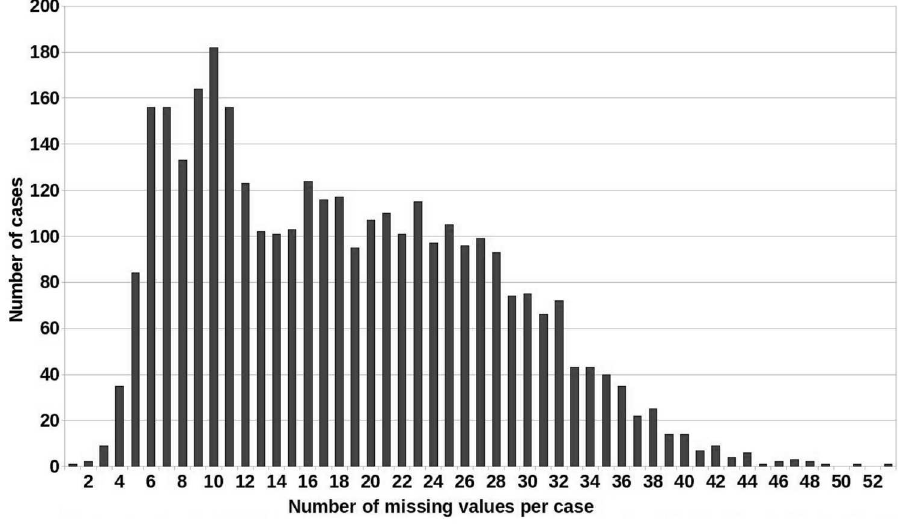
Figure 2. Number of cases as a function of the number of missing values per case in the multinational European fecundability study data set (Colombo & Masarotto,